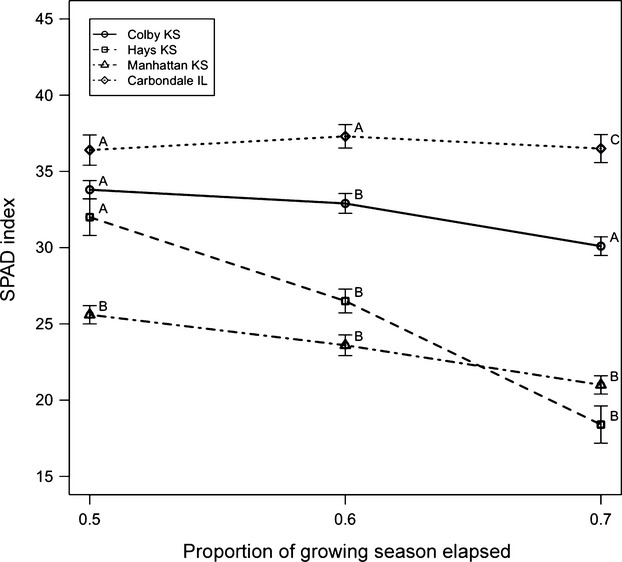
SPAD values (least squares mean estimates ± SE) for each planting site as a function of proportion of growing season elapsed. Higher numbers reflect higher chlorophyll content. A, B letters indicate significant differences among sites at a given GDD. Diamond = Carbondale, circle = Colby, square = Hays, triangle = Manhattan.